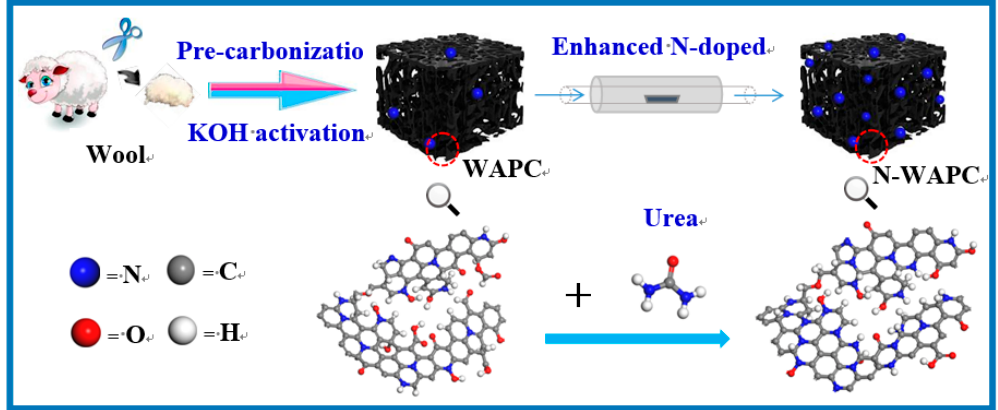
Figure 1. Schematic illustration of the synthesis of enhanced N ‐ doped porous carbon.